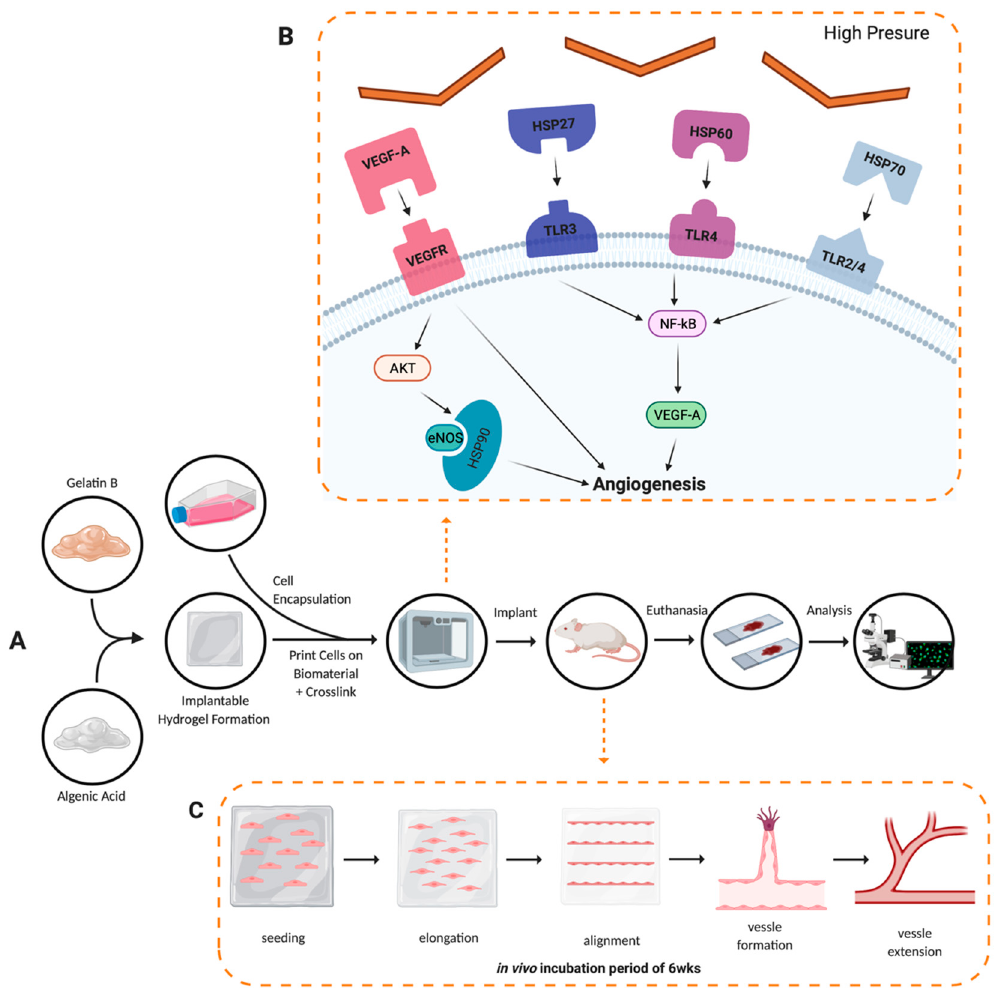
Figure 6. Angiogenesis development conceptual model. ( A ) Experimental procedure followed throughout the project, solid black arrows represent the observable progression of the project; dashed orange arrows denote a theoretical representation of angiogenic development. ( B ) Cellular pathway activation by thermal inkjet printing technologies, droplets of bioink are heated, binding VEGF-A to VEGFR, HSP27 to TLR3, HSP60 to TLR4, and HSP70 to TLR2/4, all leading to the angiogenesis seen in the analysis of tissues procured [20]. ( C ) Alginate/gelatin hydrogel degradation and vessel formation of the human microvascular endothelial cells via the inkjet-printing process.